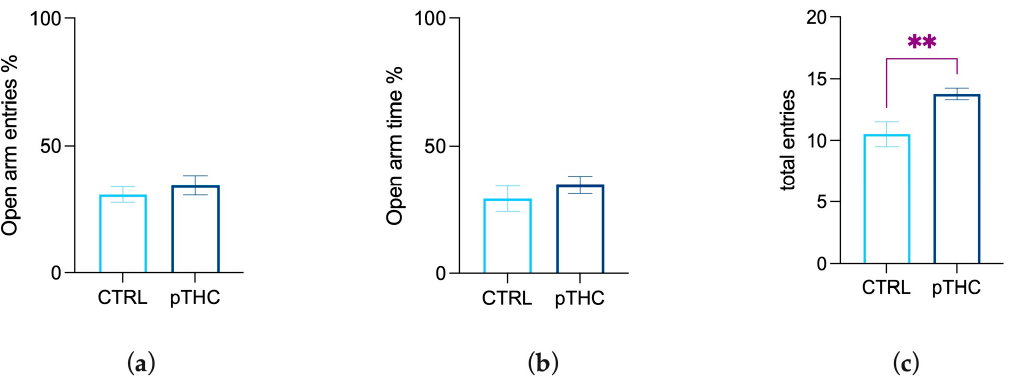
Figure 3. Effects of prenatal TCH exposure (2 mg/kg) on emotional reactivity of the adolescent male rat offspring in the EPM: ( a ) Prenatal exposure to THC did not affect the percentage of time spent on the open arm and ( b ) on the percentage of entries in the open arm, while ( c ) increasing the number of total entries. Each bar represents the mean of n = 12 rats; error bars indicate SEM. ** p < 0.01; CTRL = male rat offspring prenatally exposed to Veh; pTHC = male rat offspring prenatally exposed to THC; Open arm time % = the percentage of time spent on the open arm/total time spent on open and closed arms; Open arm entries % = the percentage of the number of entries in the open arm/number of entries in the open and closed arms.